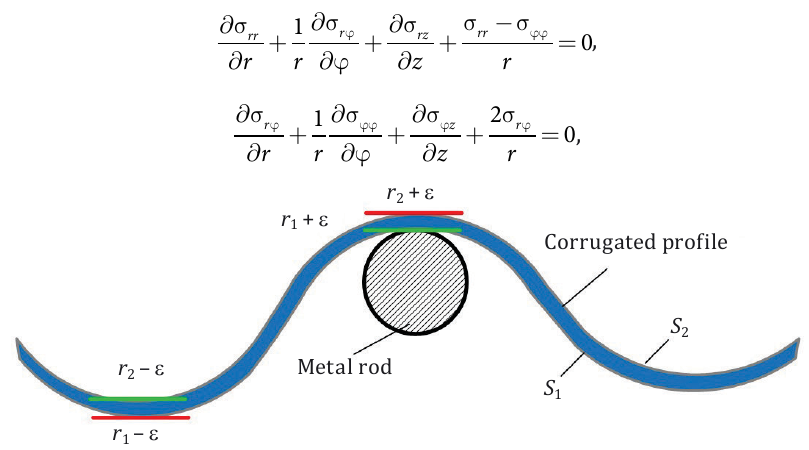
Figure 4. Scheme to the description of the mathematical model of the